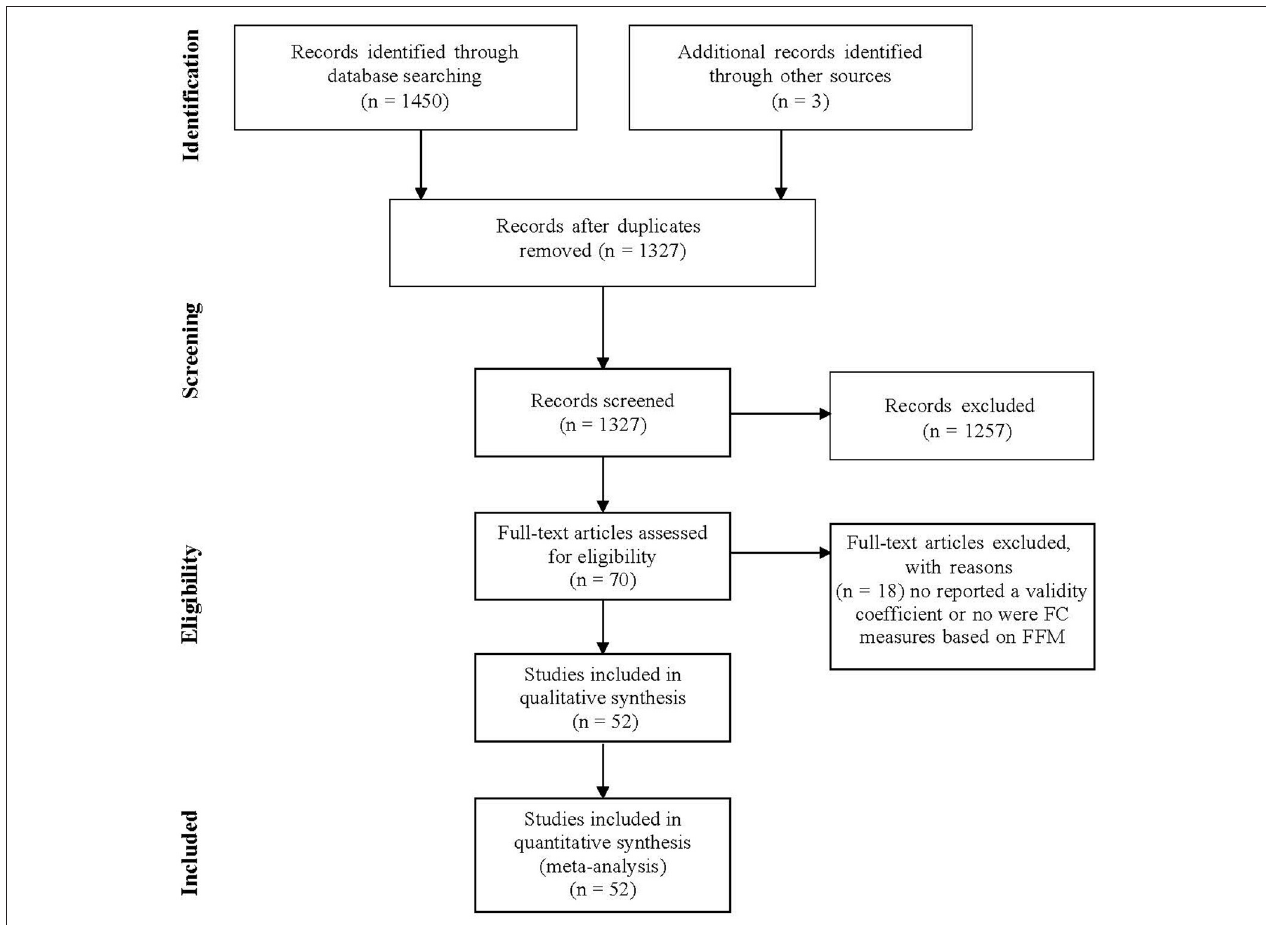
FIGURE 1 | PRISMA flow diagram of excluded and included